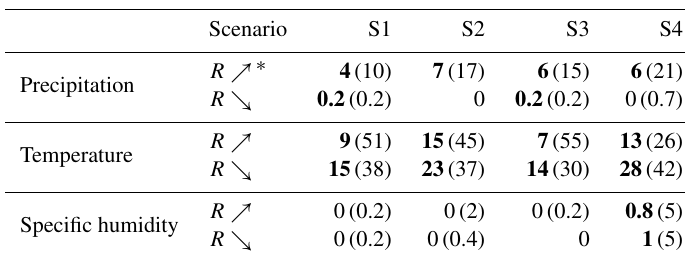
Table 3. Cross-comparison of the areal proportions (%) with different dominant driving factors and changing directions of runoff ( R ) in the future scenarios S1 (RCP4.5/2030s), S2 (RCP4.5/2080s), S3 (RCP8.5/2030s), and S4 (RCP8.5/2080s). The areas where a variable is the largest driving factor identified by multi-model ensemble means is marked in parentheses. The areas where a variable is identified as the “dominant” factor are in bold. A climate variable is identified as the “dominant” one only when 80% or more of the 20 GCMs agree that it is the largest driving factor of runoff